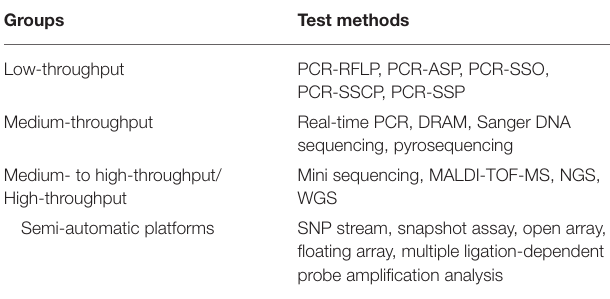
TABLE 1 | Blood group genotyping